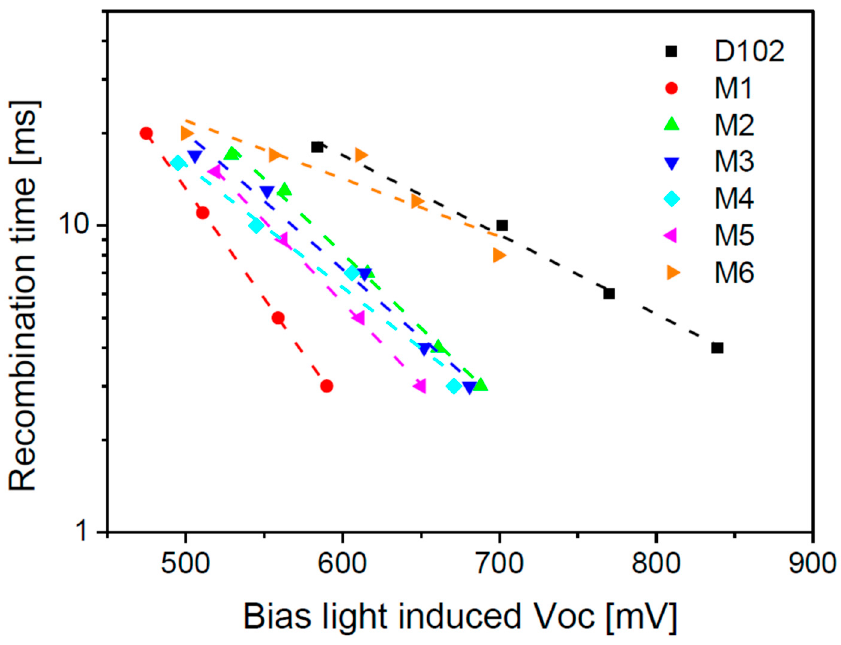
Figure 6. Electron recombination lifetime as a function of Voc in chlorin- and D102 based ssDSSCs.